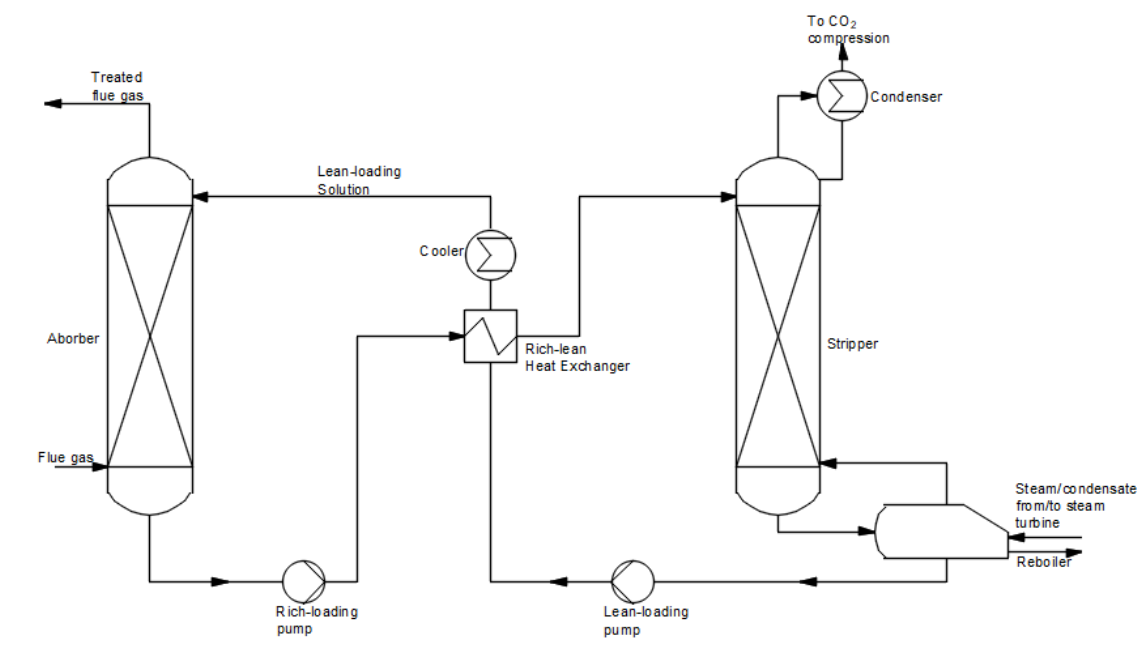
Figure 5. Scheme of the post-combustion CO 2 capture method using a chemical absorption process (based on [22]).